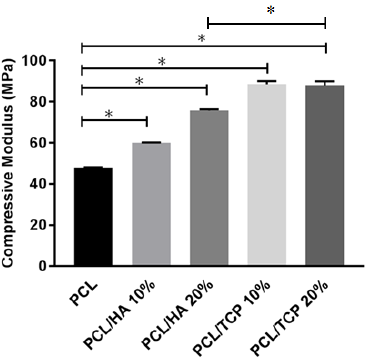
Figure 5. The compressive modulus of different materials. * Statistical evidence ( (cid:1868) (cid:3407) 0.05 ) using one ‐ way analysis of variance (ANOVA) with Tukey